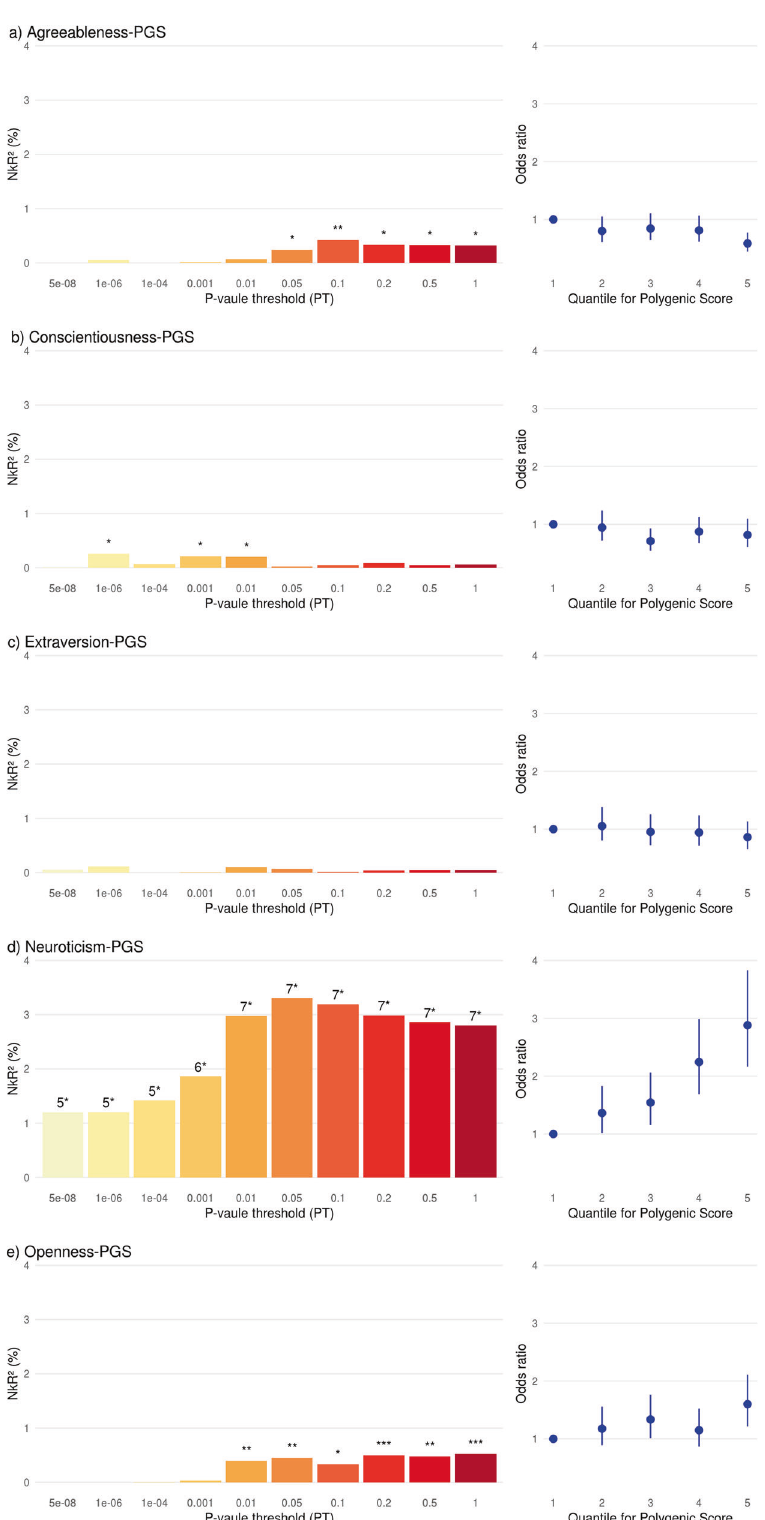
Fig. 3 Association of Big Five Polygenic Scores (PGS) with Borderline Personality Disorder case-control status. Left panels: Proportion of explained variance in case-control status ( Nagelkerke R² ) depicted for the ten tested p value thresholds (PT). Right panels: Odds Ratio for BPD by PGS quintile, with decile 1 as reference. Regressions were computed with the fi rst 10 ancestry principle components to adjust for population strati fi cation. * p < 0.05; ** p < 0.005 (0.05/10 tested p -value thresholds per PGS); *** p < 0.001 (0.05/10 tested p -value thresholds /5 personality traits); 4* p < 1*10 − 4 ; 5* p < 1*10 − 5 ; 6* p < 1*10 − 8 ; 7* p < 1*10 − 12 . Neuroticism-PGS was based on Nagel et al. [23], the other BIG-5 personality traits PGS were based on Lo et al.